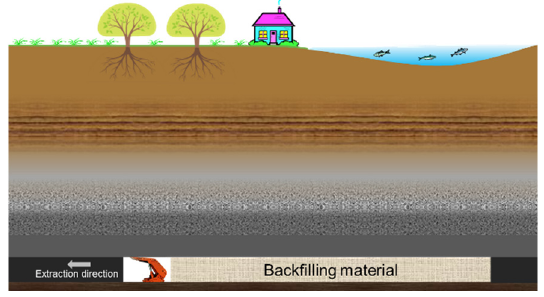
Figure 3. Current mechanised mining with backfilling procedure employed (drawing designed by Xiaowei